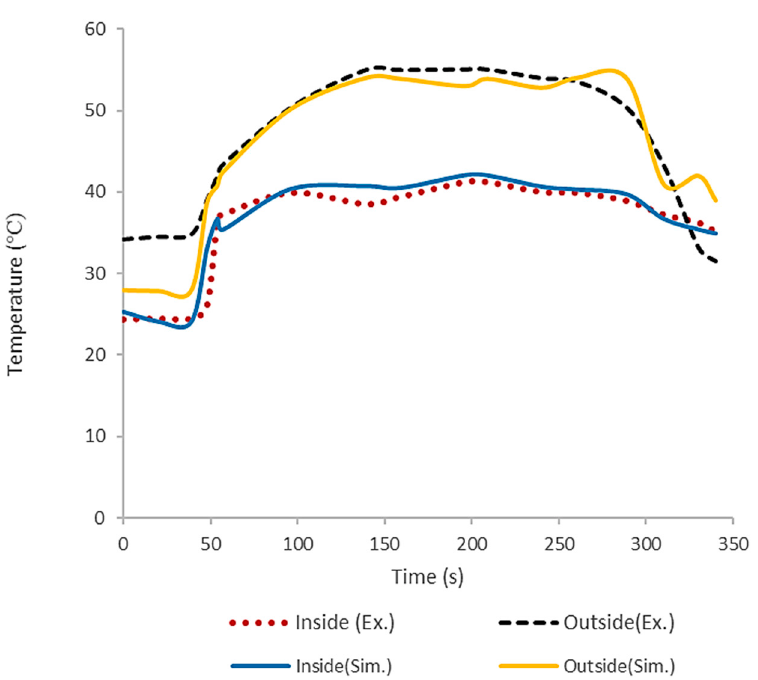
Figure 8. Temperature nephogram at specific points inside and outside of the sample during the heat treatment process. Under the tested conditions, the developed computational conduction model pre- dicted accurately the temperature distribution, on the bark surface and inside the phloem, during the heat treatment, with an error of 1–4% (Figure 8 and Table 4).